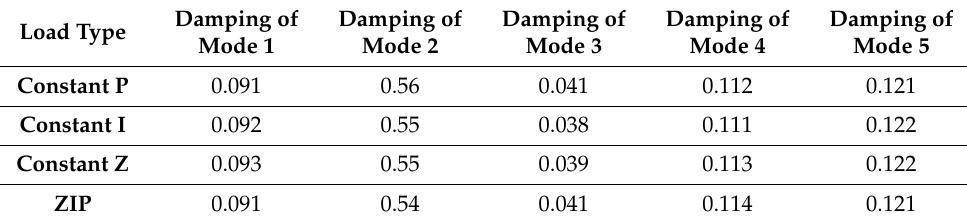
Figure 8. Impact of the variation in load power on the DC grid. Table 6. Damping performance of complete system under different loads. Table 6. Damping performance of complete system under different loads.